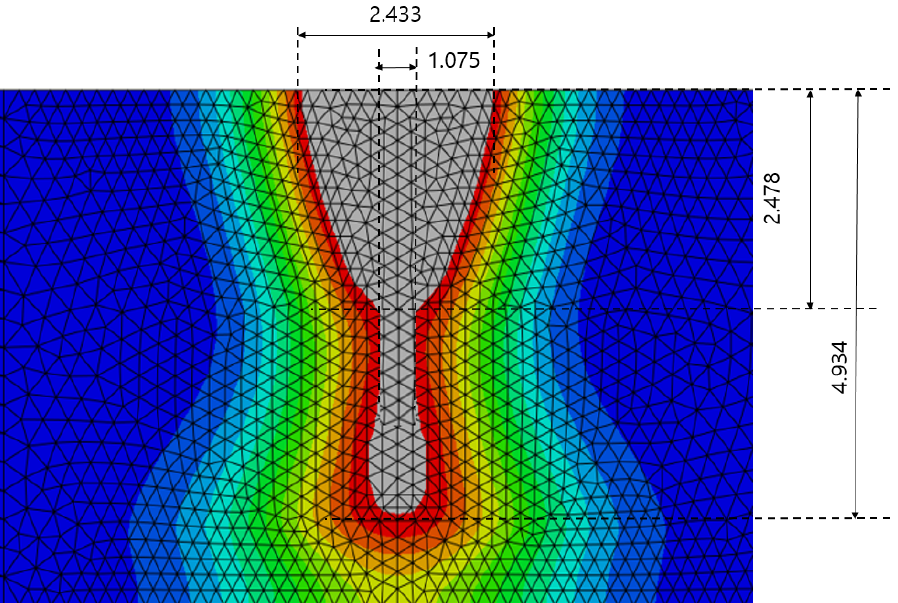
Figure 11. Heat transfer analysis results per welding speed (1.5 m/min).